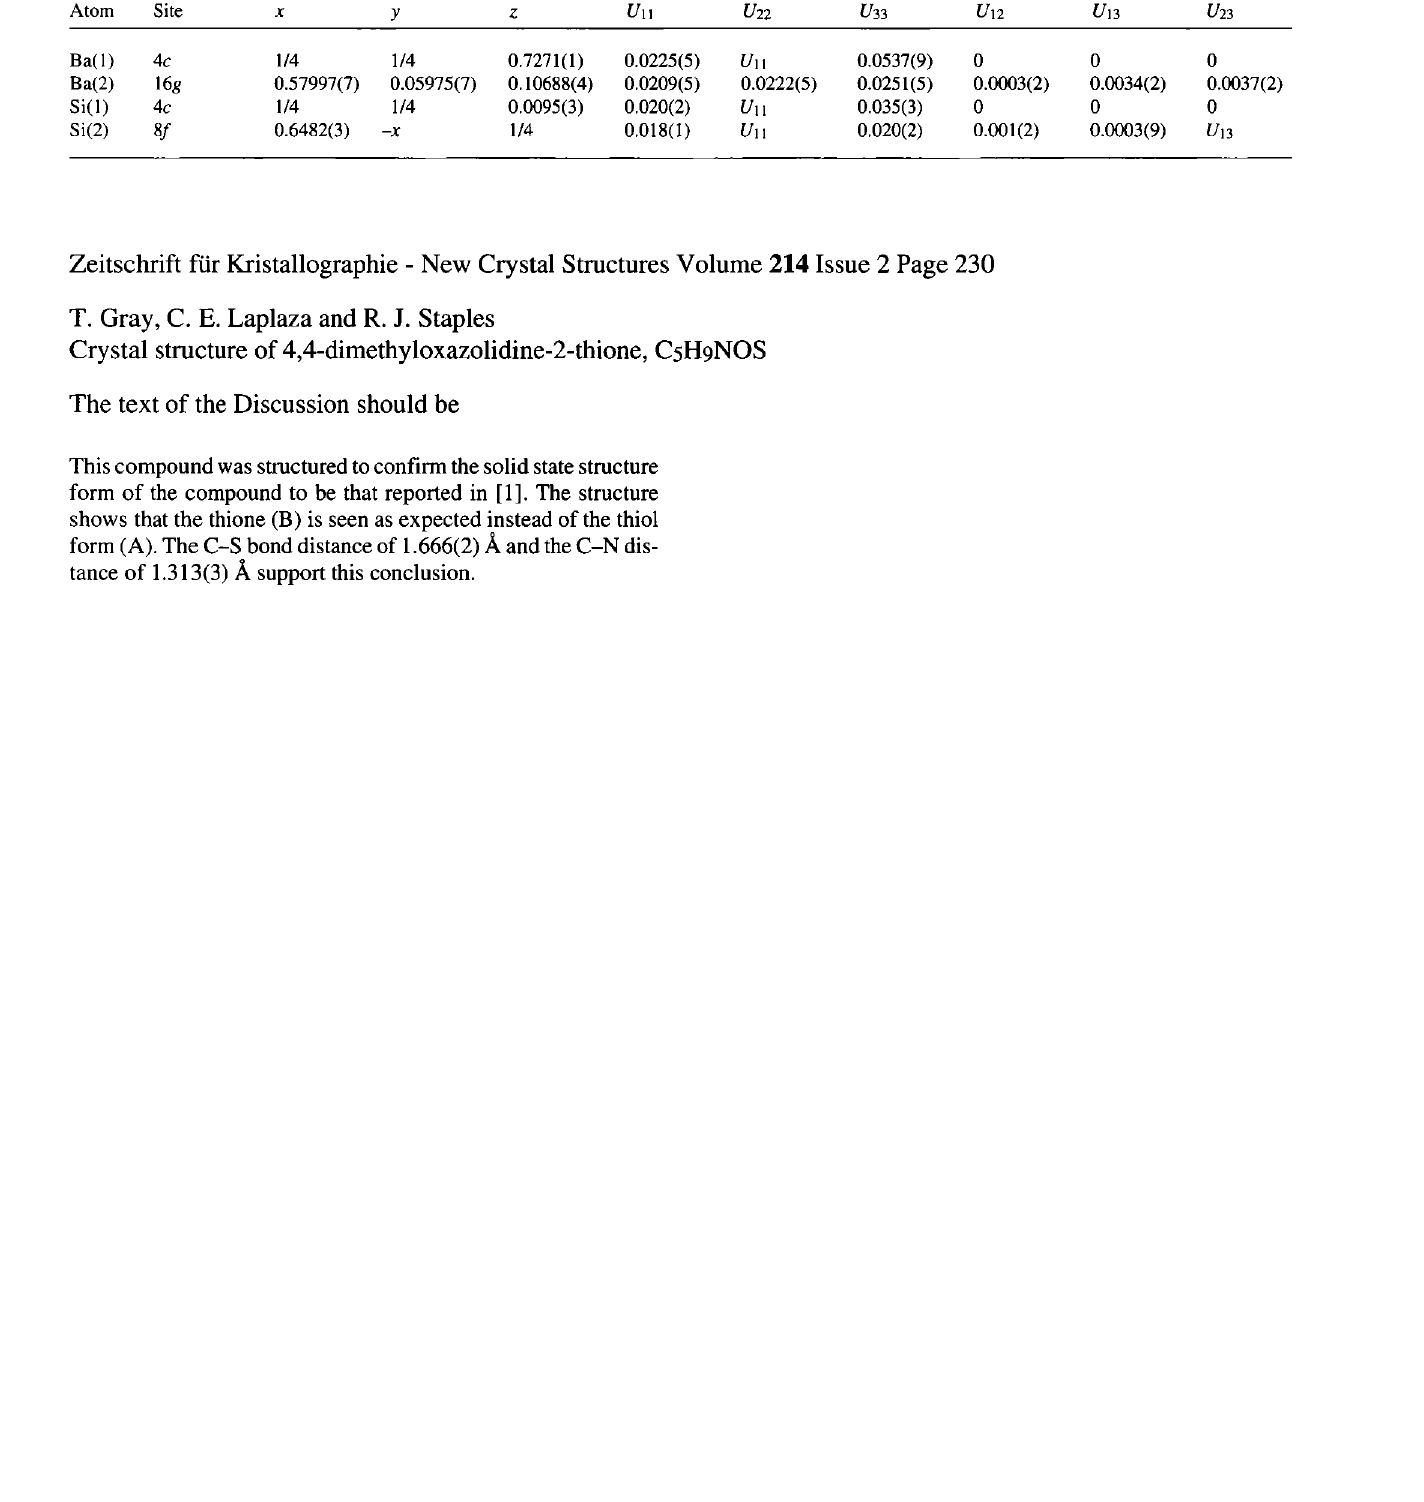
Table 2. Atomic coordinates and displacement parameters (in À 2